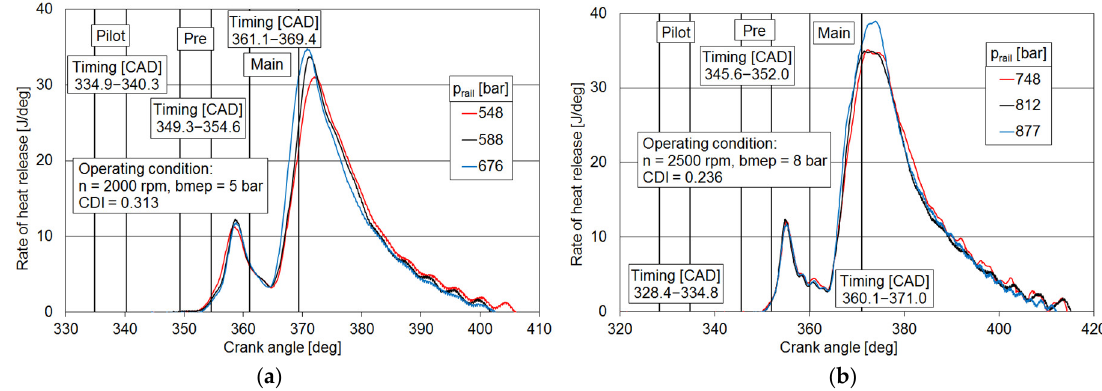
Figure 6. Influence of rail pressure control on the rate of heat release in operating condition No.2 ( a ) and No.3 ( b ).